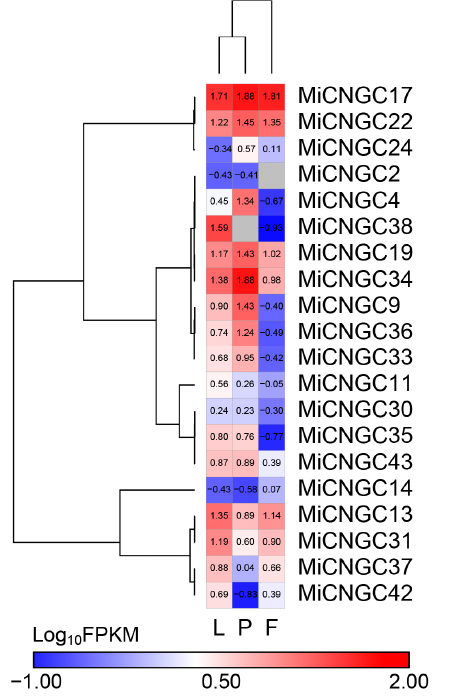
Figure 3. In silico expression of mango CNGC genes in different tissues, including leaf (L), fruit peel (P) and fruit flesh (F).